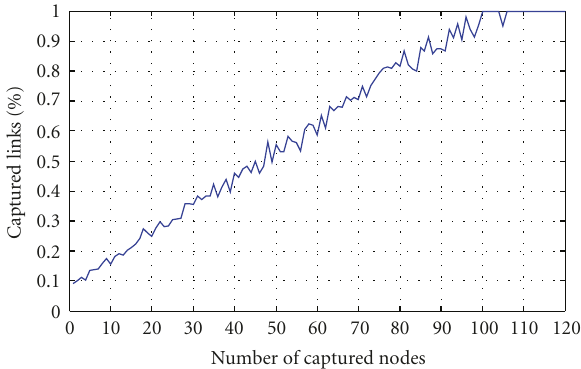
Figure 5: Percentage of corrupted links versus number of captured